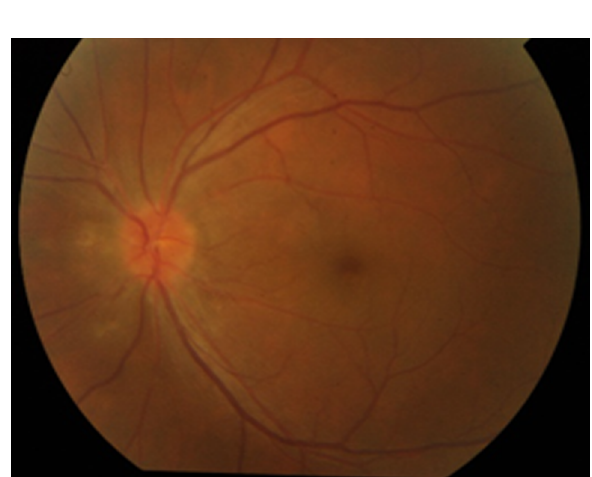
Figure 1: Fundus image of left eye showing blurred disc margins with choroidal